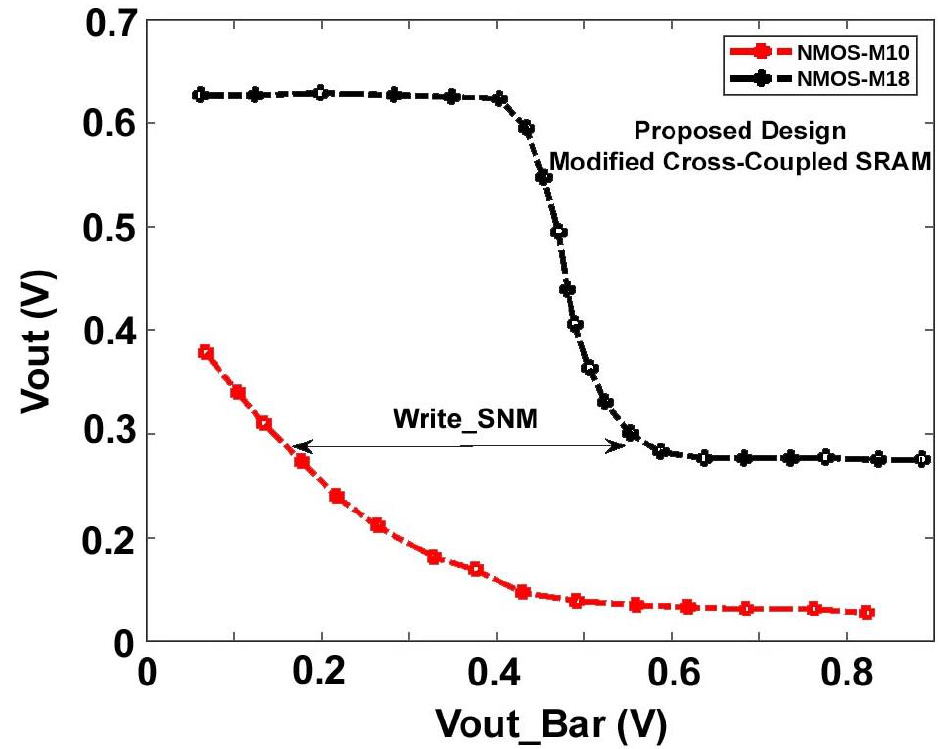
Figure 21. Write Static Noise Margin (SNM) of Proposed Sense Amplifier.